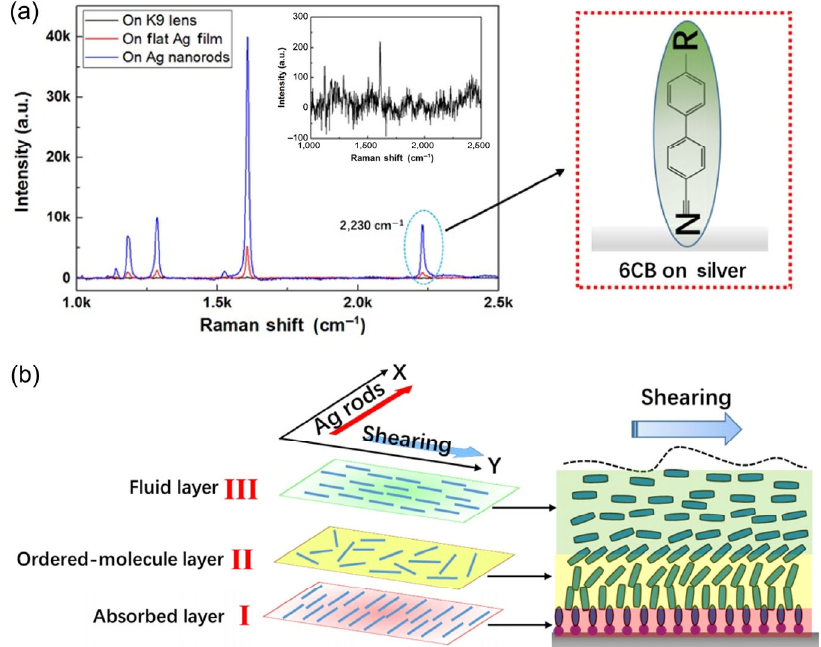
Fig. 5 (a) Raman spectra collected on the K9 lens, flat Ag film, and Ag nanorod film under shearing at a speed of 200 mm/s. The inset panel is the spectrum on the K9 lens. The adsorption of 6CB on Ag is depicted in the red rectangle; (b) illustration of 6CB alignment in a nanofilm under a shear-flow